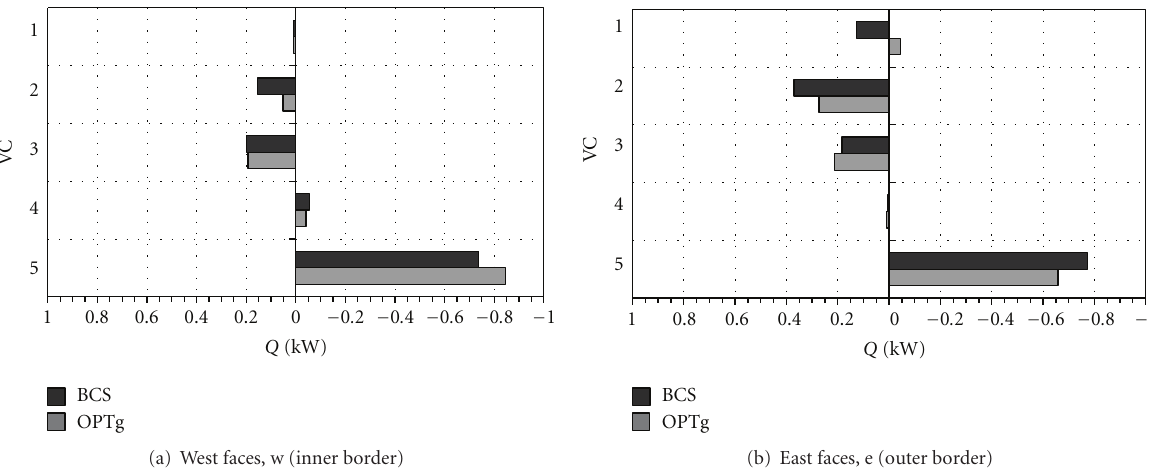
Figure 17: Enthalpic flow rate predictions across West (inner border) and East (outer border) of the air curtain control volumes, per unit length—OPTg case